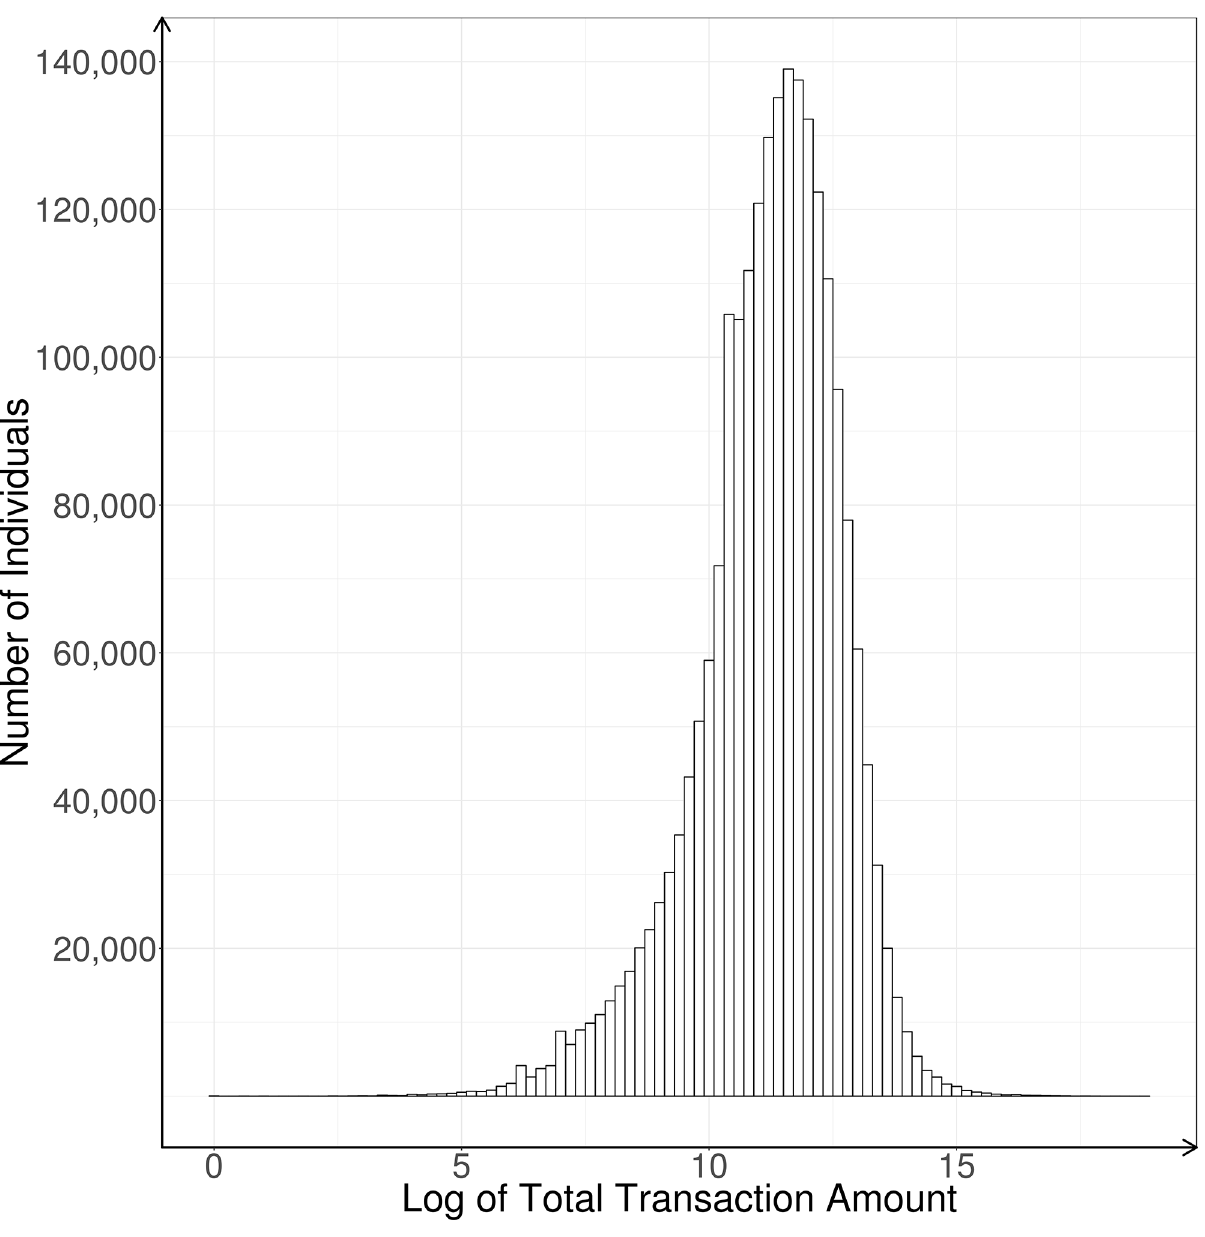
Fig 1. Distribution of credit card transaction amounts (on a log